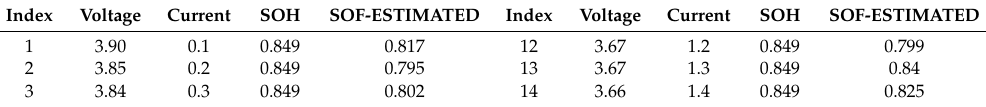
Table 1. Estimation results of the first battery.